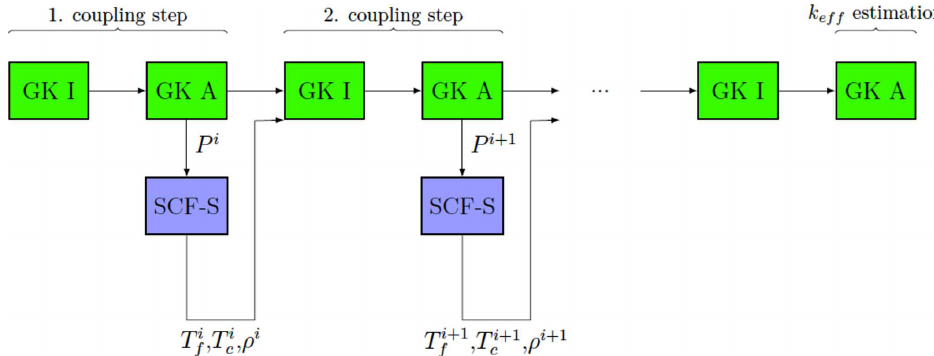
Fig. 3. Coupling scheme of static calculation (GUARDYAN, GK) and thermal-hydraulics (TH).